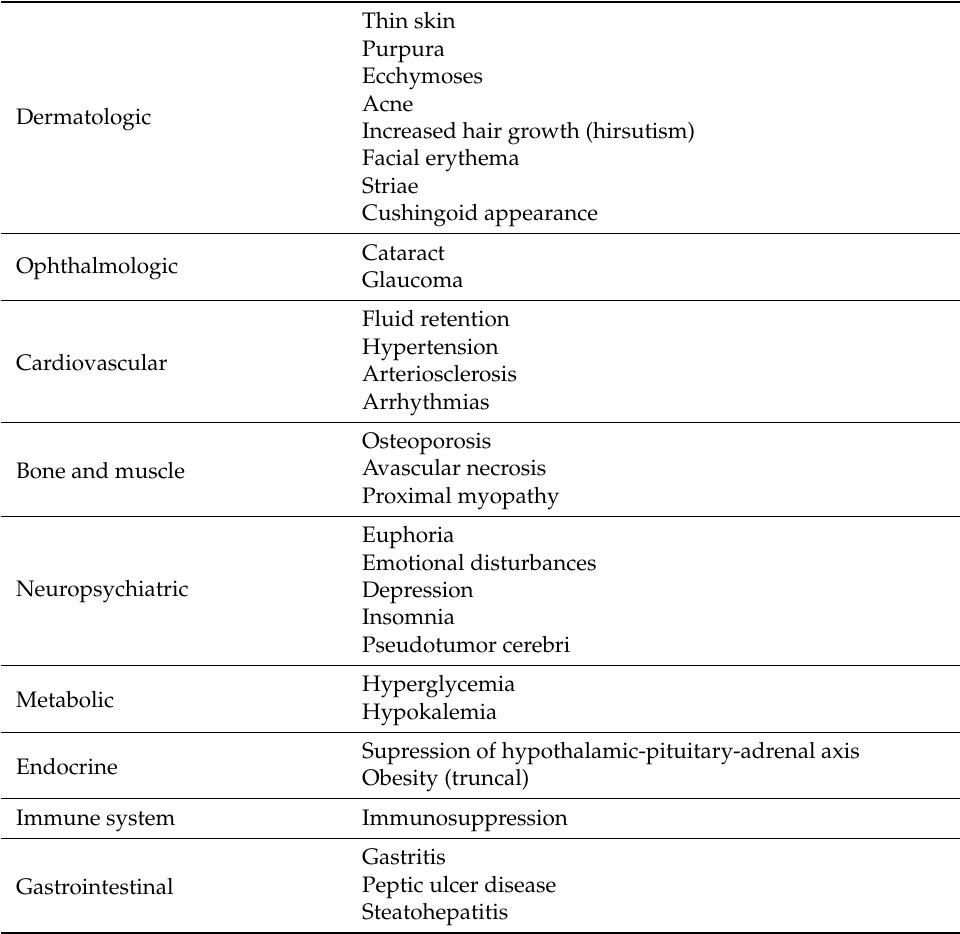
Table 2. Major side effects of systemic glucocorticoids